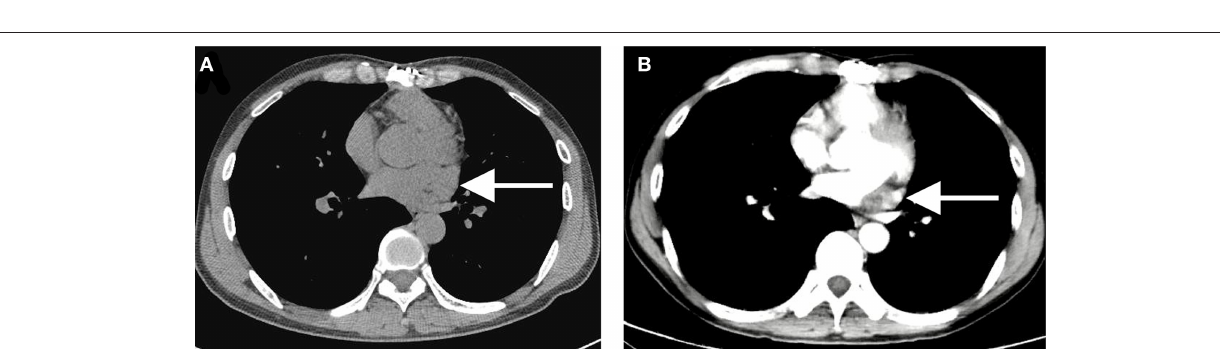
abnormal structure was found closely connected to the left atrium and left